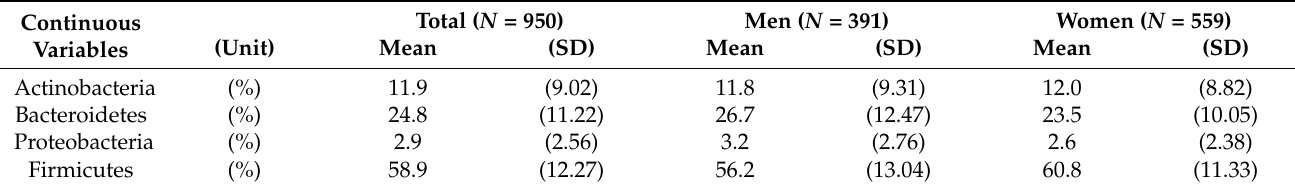
Table 2. Relative count of gut microbial major phylum in participant.